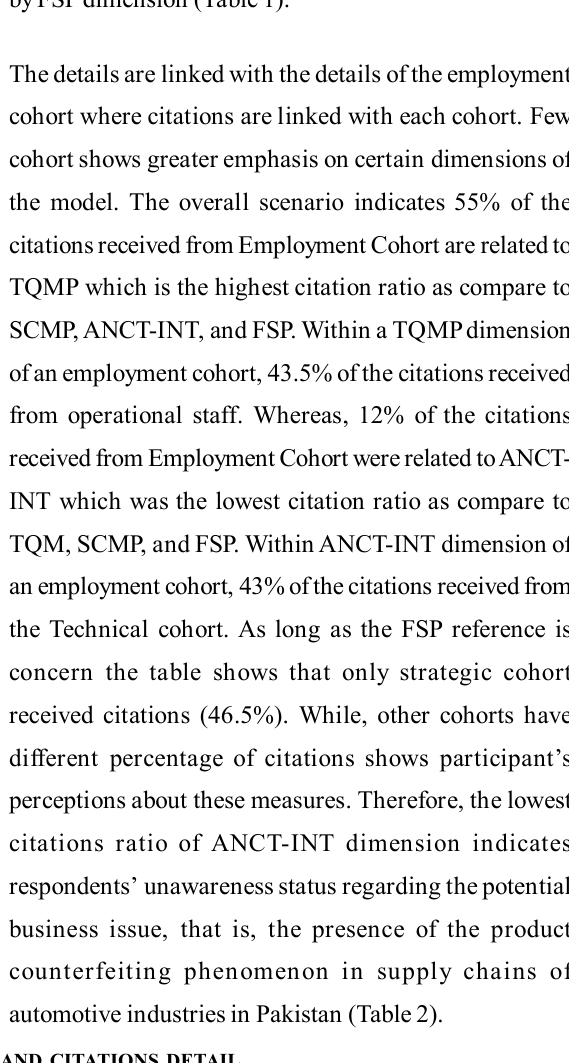
TABLE 1. MODEL DIMENSIONS AND CITATIONS